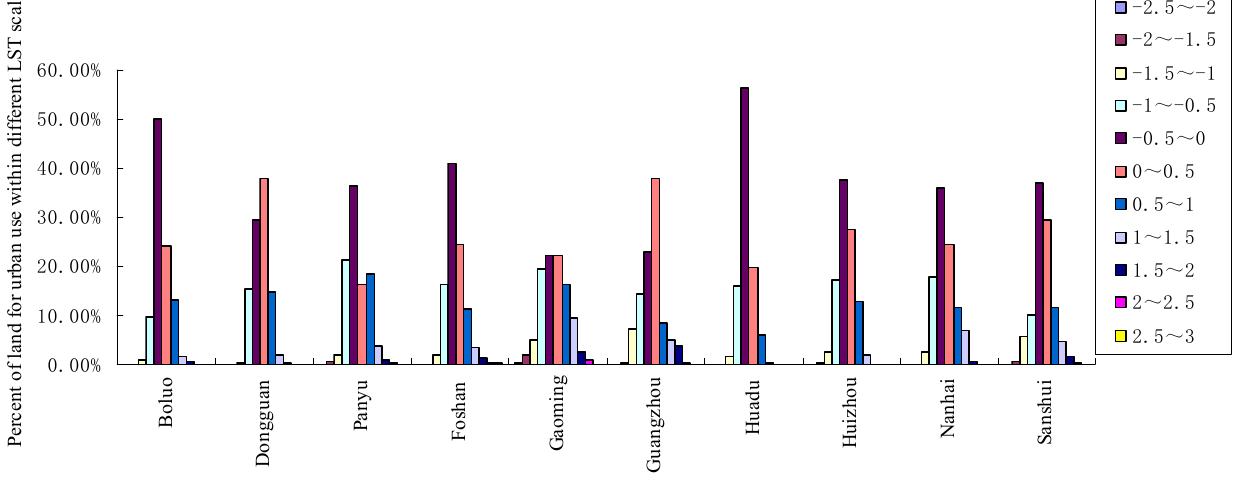
Figure 2. Percent of urban-used land within different LST scales for the ten cities in Guangdong.